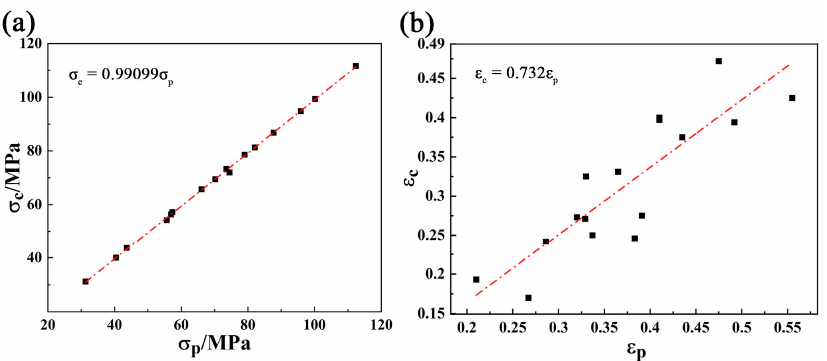
Figure 12. The linear relationship between ( a ) σ p and σ c , ( b ) ε p and ε c .